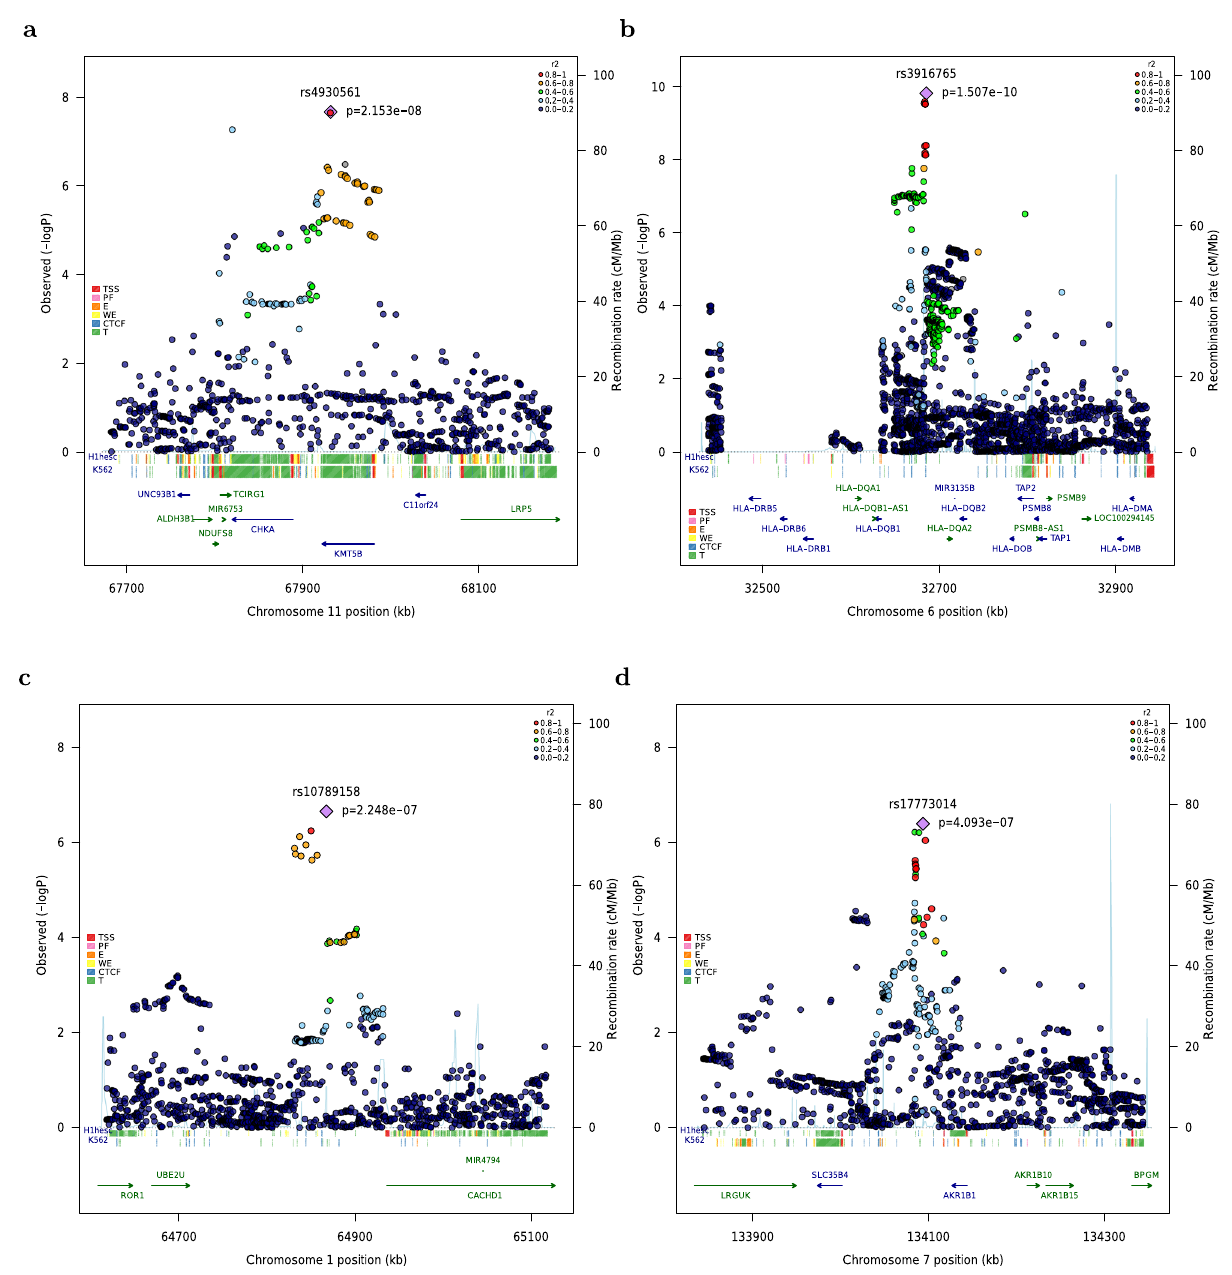
Fig. 3 Regional association and linkage disequilibrium plots for 4 new loci associated with acute myeloid leukemia. For each GWAS, association tests were performed for all AML cases and cytogenetically normal AML assuming an additive genetic model, with nominally signi fi cant principal components included in the analysis as covariates. Association summary statistics were combined for variants common to all four GWAS, in fi xed effects models using PLINK. Negative log 10 -transformed P values (left Y axis) from the meta-analysis of four GWAS are shown for SNPs at 11q13 ( a ) and 1p31.1 ( c ) for all AML irrespective of sub-type, and at 6p21.32 ( b ) and 7q33 ( d ) for cytogenetically normal AML. All statistical tests were two-sided and no adjustments were made for multiple comparisons. The lead SNP at each location is indicated by a purple diamond and the blue line shows recombination rate (right Y axis). All plotted SNPs were either directly genotyped or had an imputation score of >0.6 in all four GWAS datasets. Included are functional annotation tracks from ENCODE showing regulatory activity in H1 human embryonic stem cells (H1hesc) and K562 myeloid leukemia cells. TSS transcription start site, PF promoter fl ank, E enhancer, WE weak enhancer, CTCF CCCTC-binding factor site, T